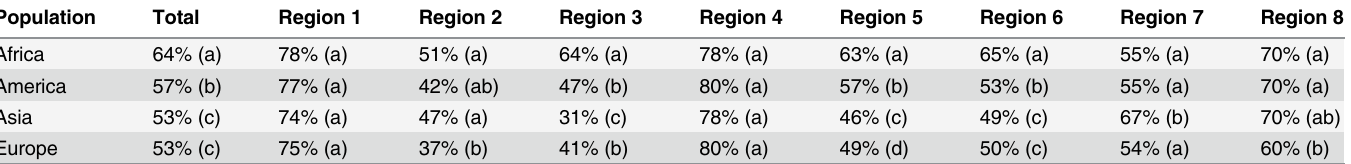
Table 3. Average nucleotide diversity for each population group and low-ILS region, relative to the X chromosome average outside the low-ILS regions. For each region, populations with the same letter code are not significantly different according to Tukey's posthoc test (5% level).